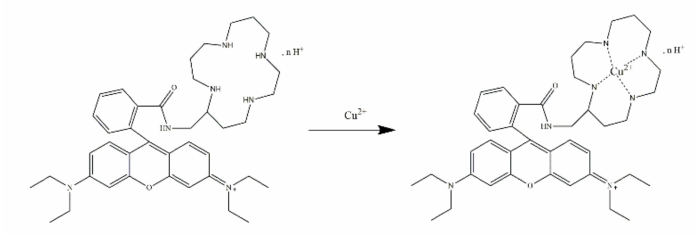
Figure 13. The proposed sensing mechanism of the prepared sensor (Table 1, No. 17) [24]. During grape wine production, copper could disorientate volatile sulfur compounds and cause turbidity formation, thus lowering the wine quality [71]. By decorating rho- damine B with a tetra azamacrocyclic ring, a probe was created to monitor the Cu 2+ in wine with a detection limit of 4.38 × 10 − 8 M (Table 1, No.18) (Figure 14) [49]. The prepared sensor responded to Cu 2+ only in acidic conditions (< pH 5.5).